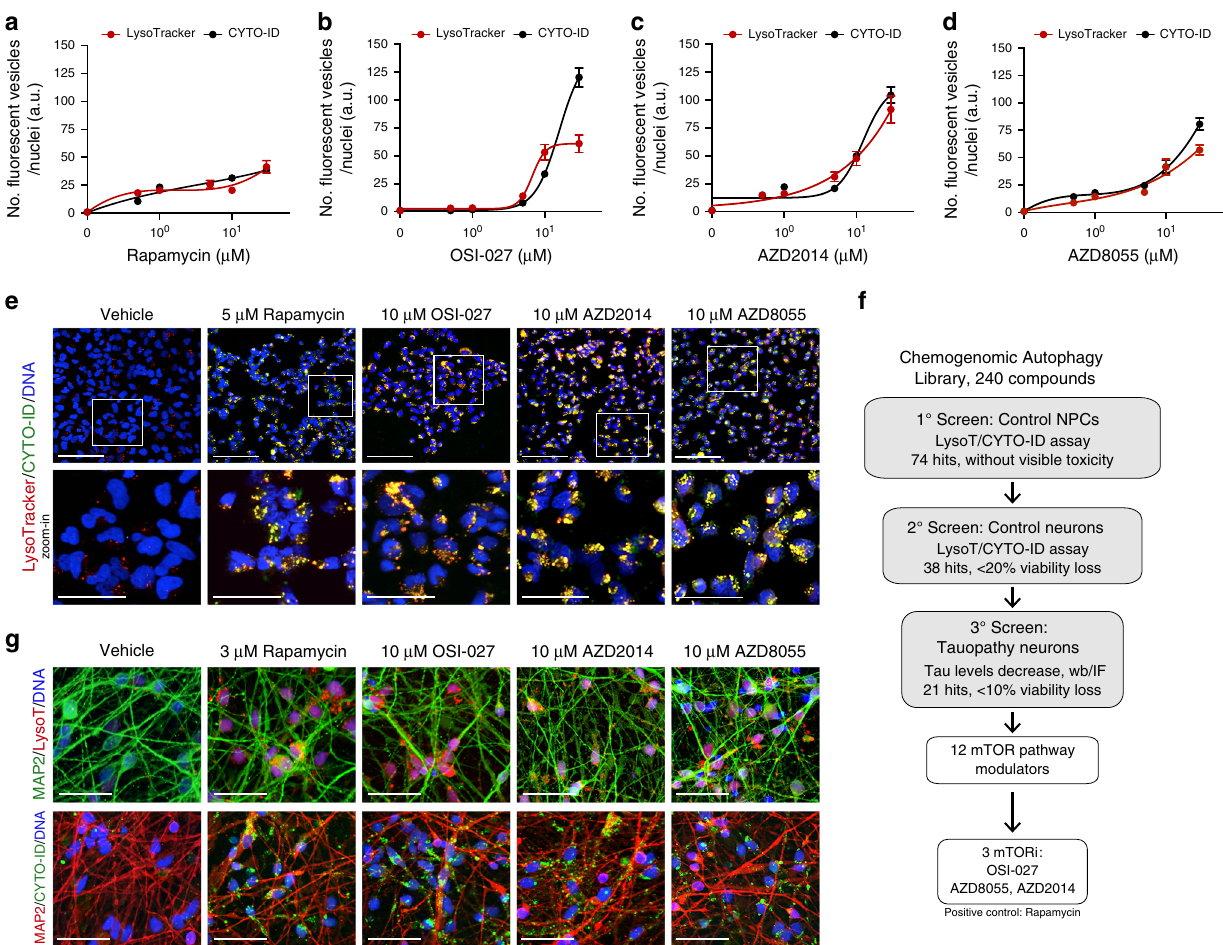
Fig. 1 Microscopy screen for compounds that activate autophagy in human Control-1 NPCs and neurons. a – d Compound dose-effect on number of LysoTracker + and CYTO-ID + fl uorescent vesicles in NPCs (8330-8-RC1), after 24 h treatment with rapamycin, OSI-027, AZD2014, and AZD8055 ( + 500 nM CQ). Data points correspond to mean number of fl uorescent vesicles per nuclei ± SEM from n = 5 biological replicates. e NPCs (8330-8-RC1) treated with compounds for 24 h at a dose that promoted maximum vesicle formation without toxicity. Scale bars are 50 μ m. Representative images from n = 5 biological replicates. Inserts correspond to zoomed-in images below (scale bars are 25 μ m). f Screening strategy followed. g Representative images of 5-week differentiated neurons (8330-8-RC1) treated with compounds for 24 h ( + 500 nM CQ). LysoTracker + (top) and CYTO-ID + (bottom) vesicles are shown in the background of MAP2 neuronal staining ( n = 3 biological replicates). Scale bars are 25 μ m. Source data are provided as a Source Data fi